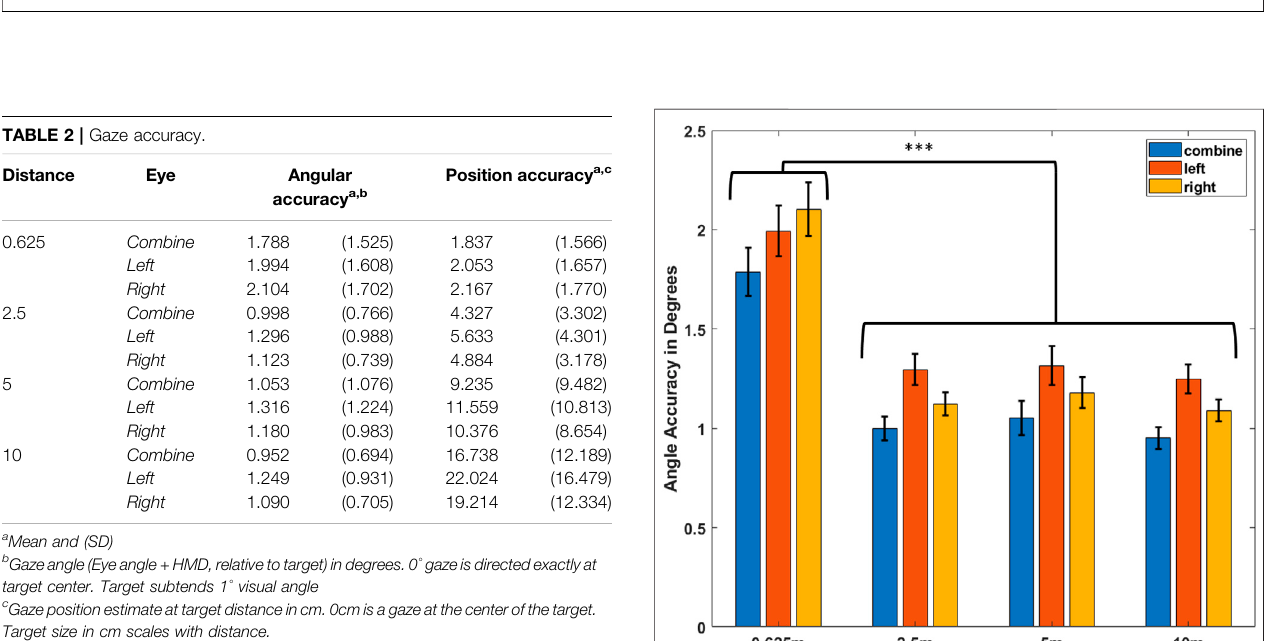
FIGURE 5 | Gaze fi xations. Each target is indicated by a red cross, presented at its average position in global coordinates (metric units). Gaze positions during fi xations are visualized in blue, for each target distance, relative to the target position. Ellipses demarcate 95% con fi dence region for each target. Note that axis scales differ across fi gures for visibility.